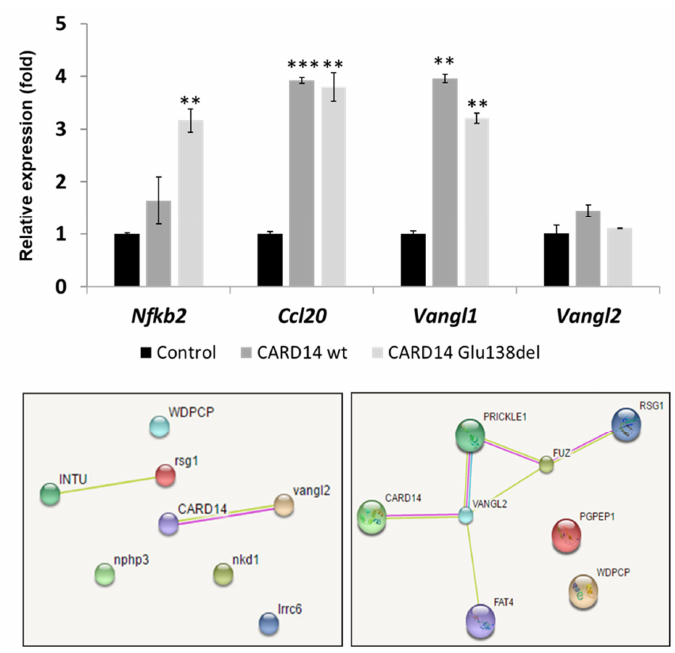
Figure 4. Effect of CARD14 overexpression on gene expression. Embryos were injected with expres- sion vectors carrying human wild type and PRP-causing CARD14 mutation (p.Glu138del). Relative expression of nfkb2 , ccl20b , vangl1 and vangl2 was ascertained 1 dpf using qPCR (upper panel). Re- sults represent the mean of 3 replicates and are provided as gene expression relative to gene expres- sion in control embryos ± standard error normalized to ppiab mRNA levels (two-sided t -test; ** p < 0.01, *** p < 0.001). Protein interaction (STRING, http://string-db.org, accessed on 17 May 2019) anal- ysis of CARD14 and planar cell polarity proteins in zebrafish (left lower panel) and human (right lower panel) is predictive of a functional interaction between CARD14 and VANGL2.